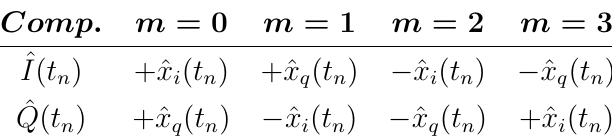
Table 1. Interpolated in-phase and quadrature components using an odd value for M